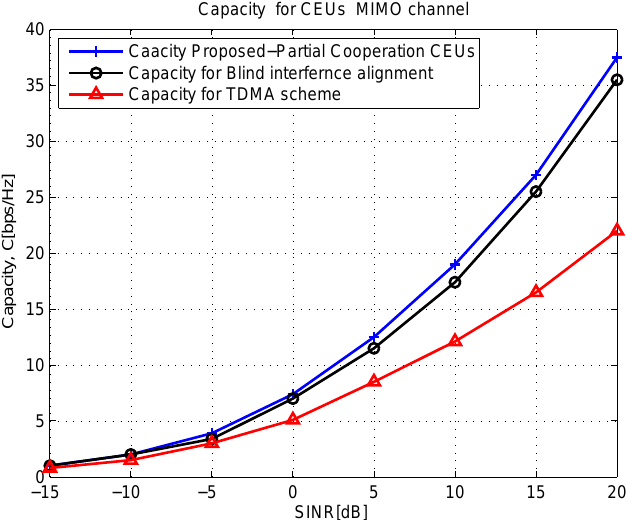
Figure 9. Comparison of Capacity with Partial, Blind and time division multiple access (TDMA)